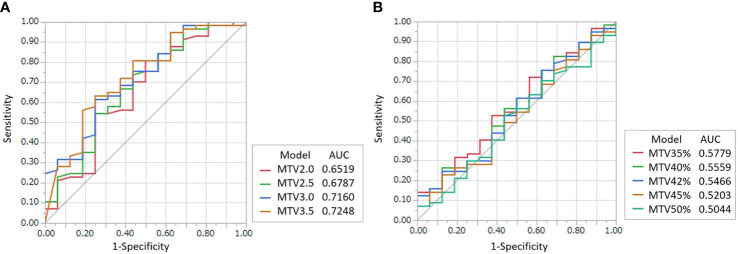
ROC curves for determining the optimal threshold value of the fixed-absolute threshold method of MTV (A) and that of the fixed-relative threshold method of MTV (B) for predicting 1-year DSS. The threshold values for the fixed-absolute threshold method were 2.0, 2.5, 3.0 and 3.5. The threshold values for the fixed-relative threshold method were 35%, 40%, 42%, 45% and 50%. The tables on the right of the graphs show area under the curve (AUC) with 95% confidence intervals. The MTV using the 3.5 absolute-threshold value was the best predictor for DSS (AUC: 0.7248).